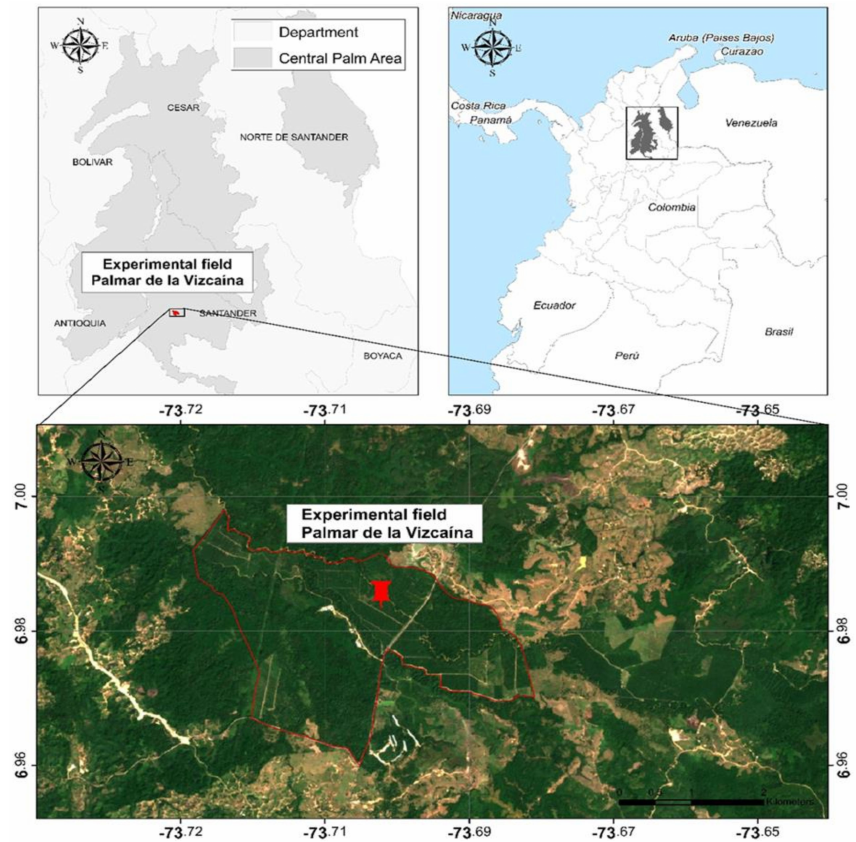
Figure 1. Location of study area, central palm zone, Palmar de la Vizca í na Experimental Station, Santander,